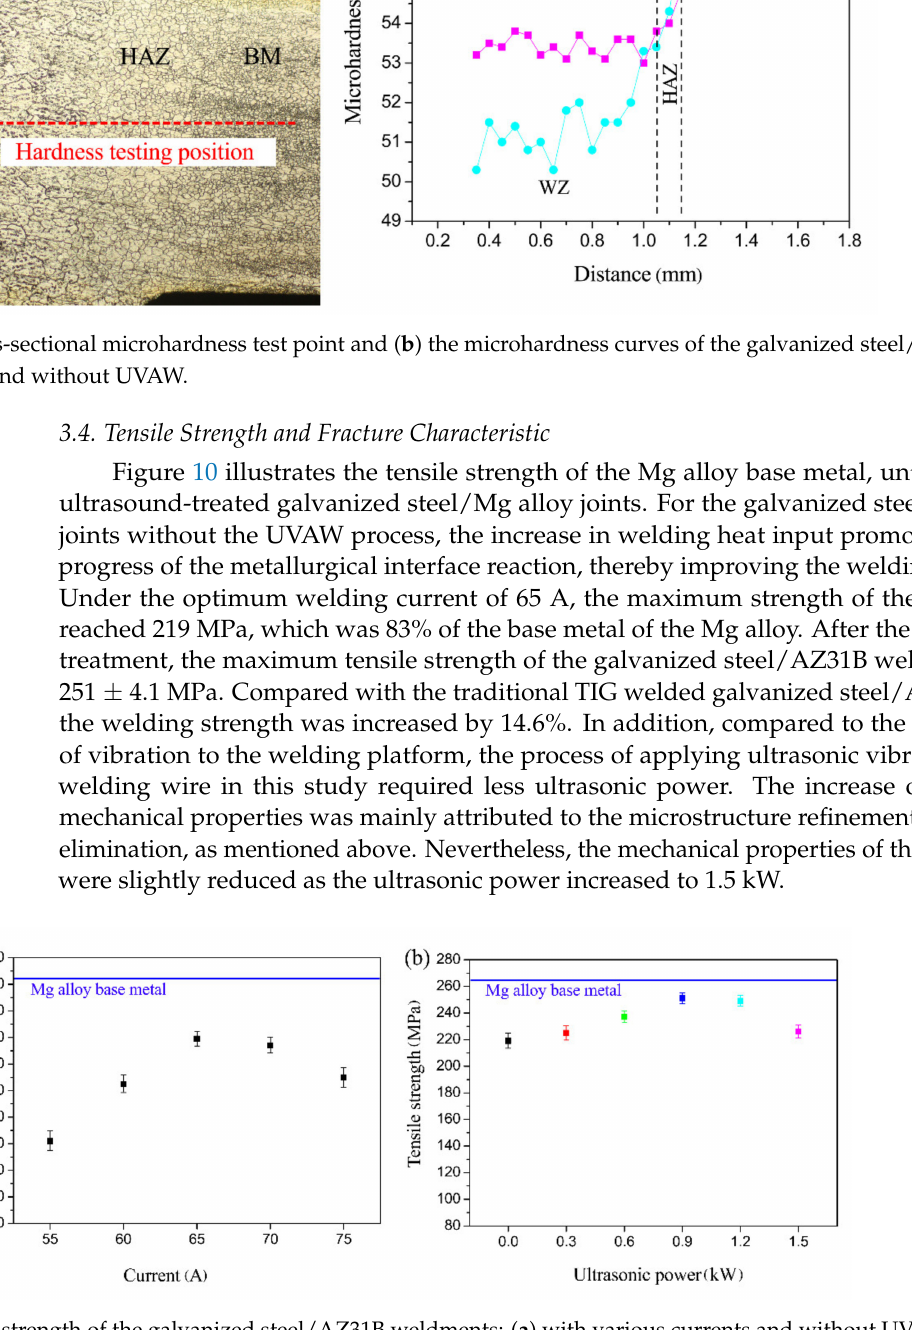
Figure 10. The tensile strength of the galvanized steel/AZ31B weldments: ( a ) with various currents and without UVAW; ( b ) with a current of 65 A and varying ultrasonic